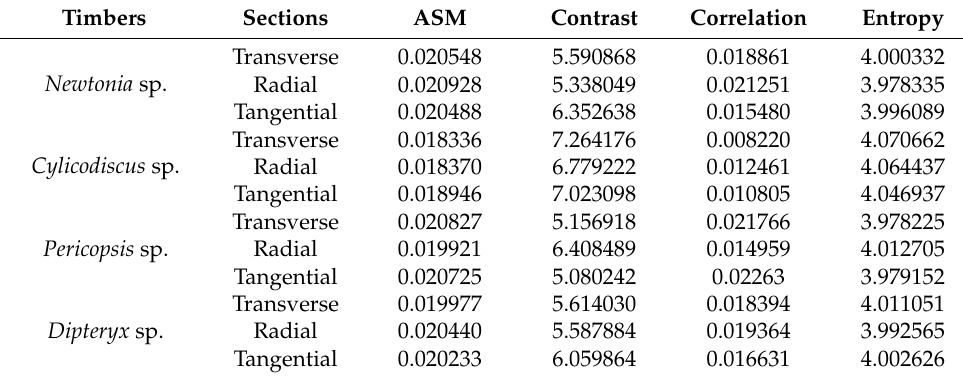
Figure 2. The three sections of the surface digital images from four timbers. Table 4. GLCM features of four timbers.